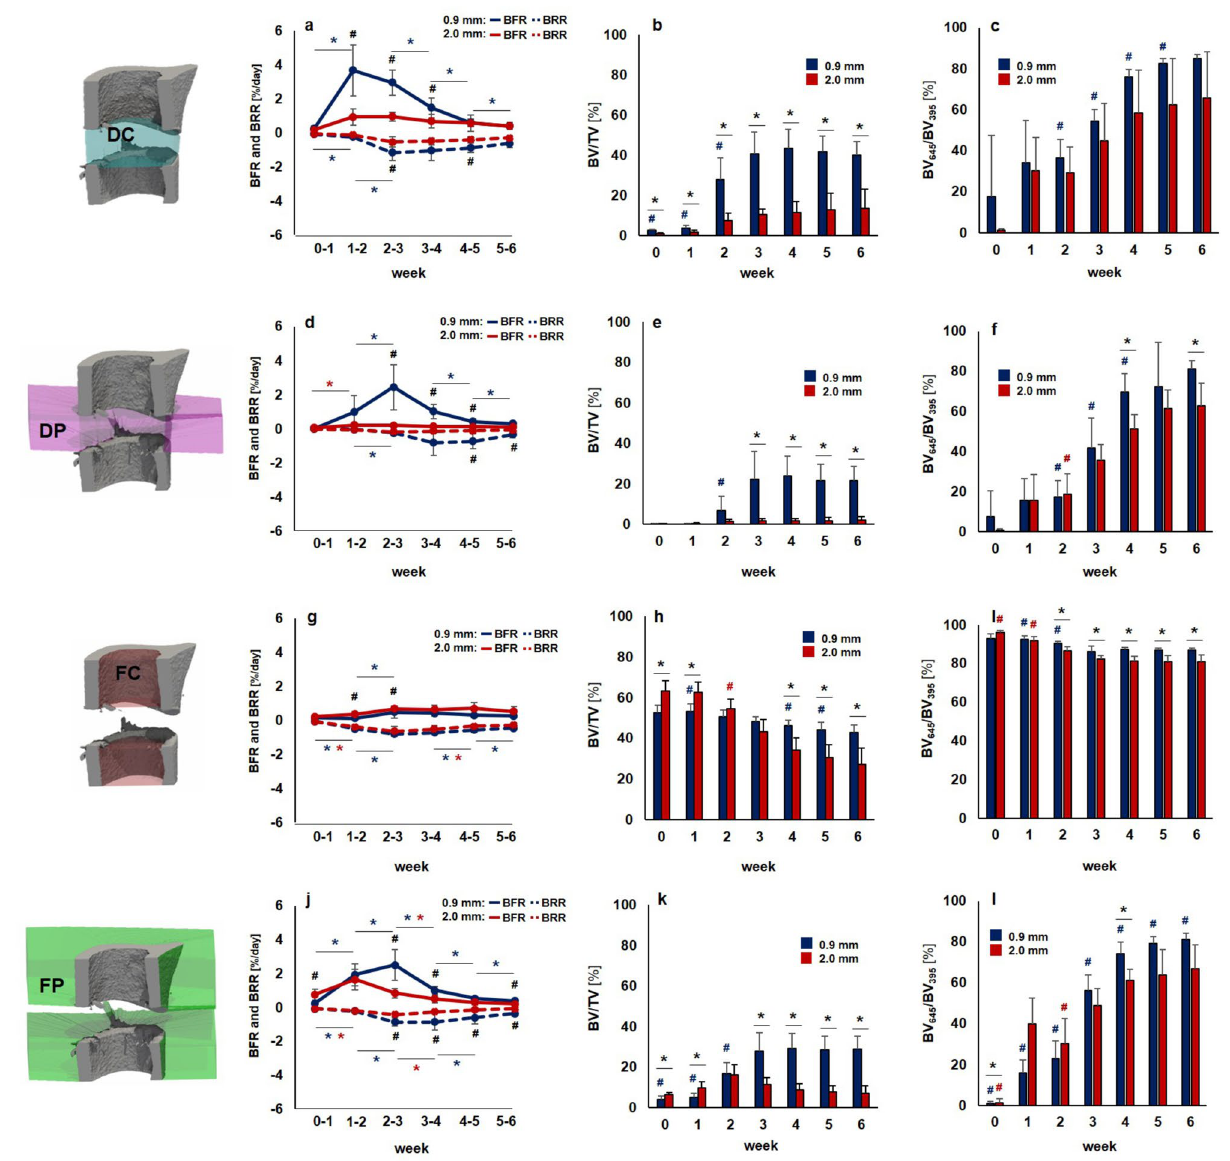
Figure 2. Micro-CT based evaluation of bone parameters in the 0.9 mm group (blue) and the 2.0 mm group (red) using different VOIS: defect center (DC; a – c ), defect periphery (DP; d – f ), cortical fragment center (FC; g – i ), cortical fragment periphery (FP; j – l ). ( a , d , g , j ) Bone formation rate (solid line) and bone resorption rate (dashed line) given in percent per day. ( b , e , h , k ) Bone volume (BV) normalized to TV (DC for DC and DP, FC for FC + FP). ( c , f , i , l ) Degree of bone mineralization given as ratio of bone volume with a density ≥ 645 mg HA/ cm 3 to the total osseous volume (threshold ≥ 395 mg HA/cm 3 ). n = 7/10; ( a , d , g , j ) *indicates p < 0.05 between consecutive weeks; # indicates p < 0.05 between groups. ( b , c , e , f , h , I , k , l ) *indicates p < 0.05 between groups; # indicates p < 0.05 between consecutive